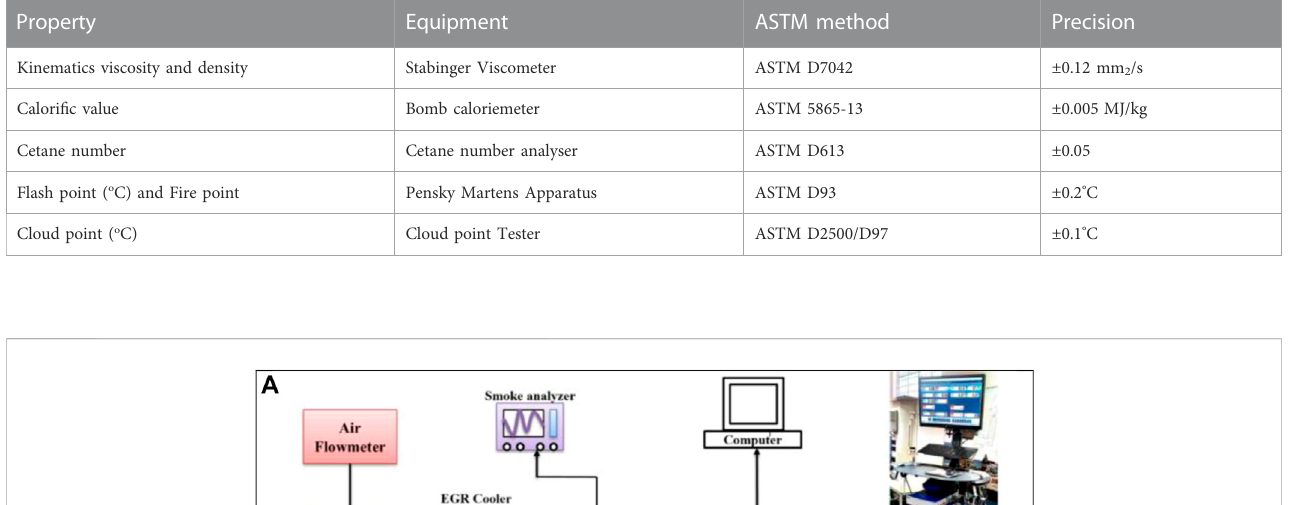
TABLE 2 The Details of the equipment ’ s speci fi cations used for fuel sample property measurement.